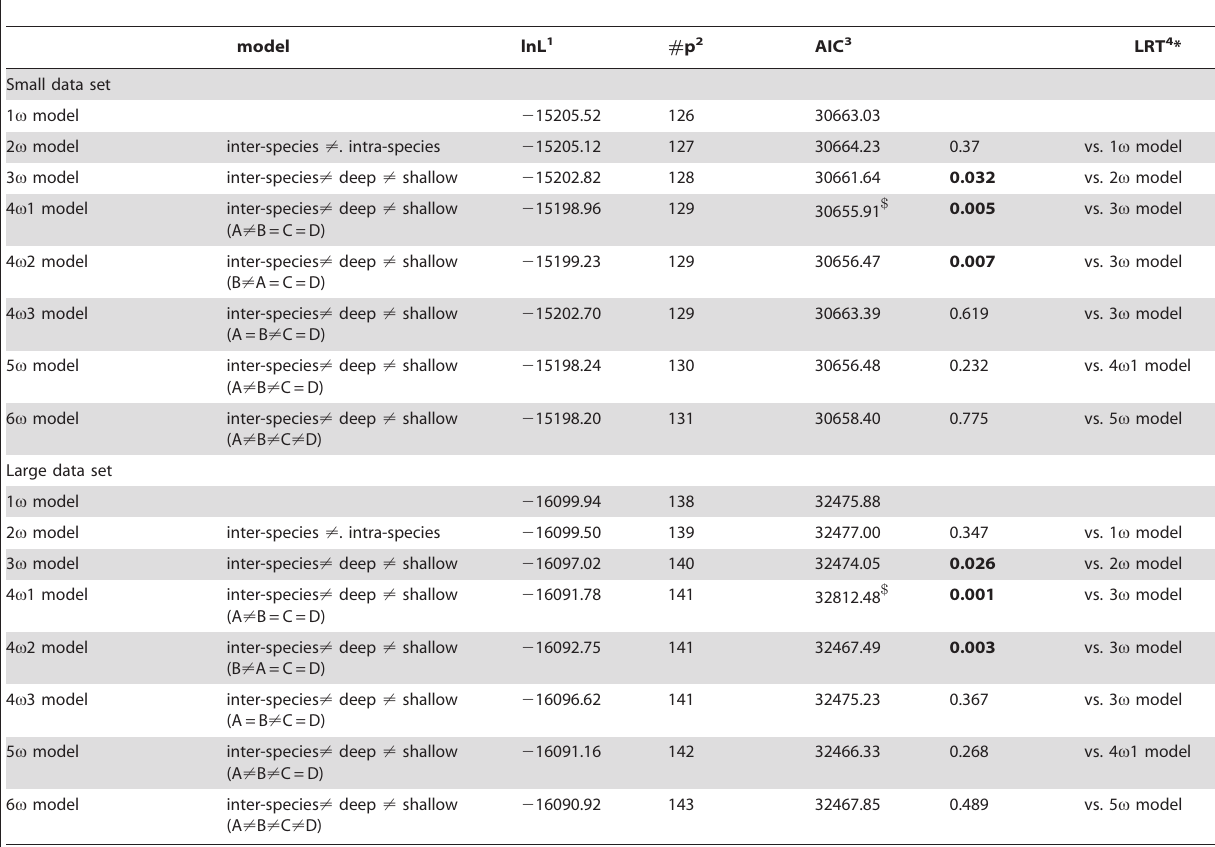
Table 2. The model comparisons for the different v ratios in the shallow